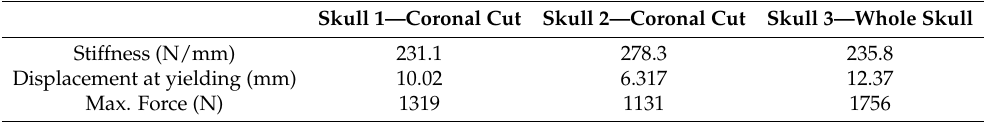
Table 4. Mechanical properties of specimens subjected to frontal point-loading